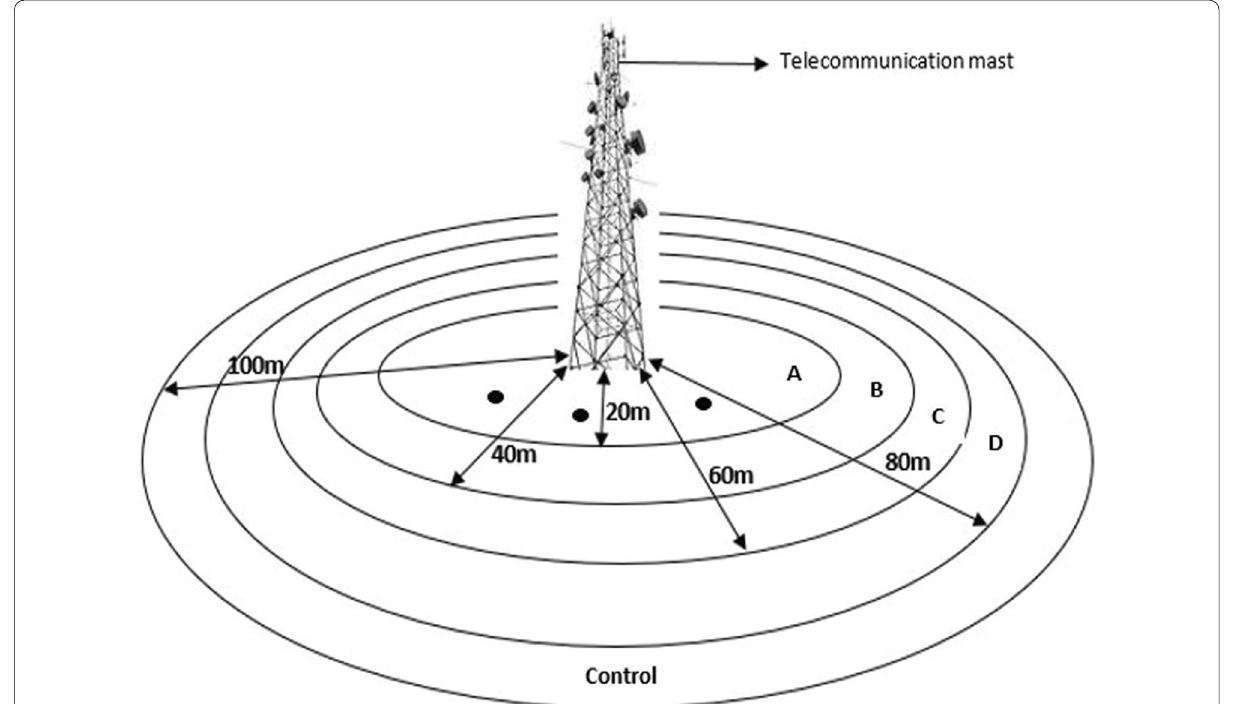
Fig. 2 Schematic diagram showing sampling stations and collection points